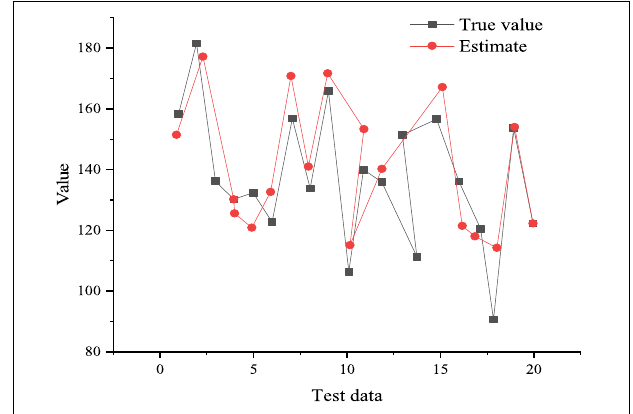
FIGURE 9 | Comparison of estimated value and output